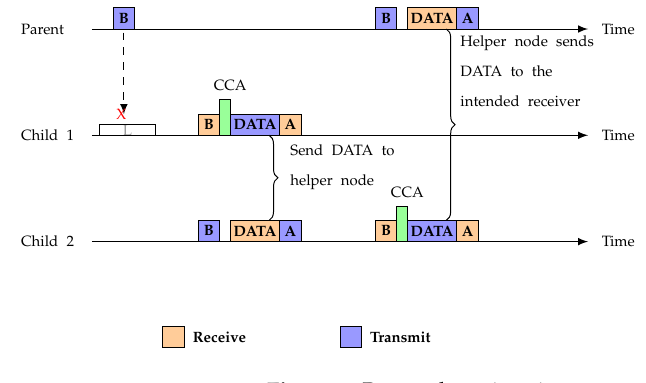
Figure 7. Beacon loss